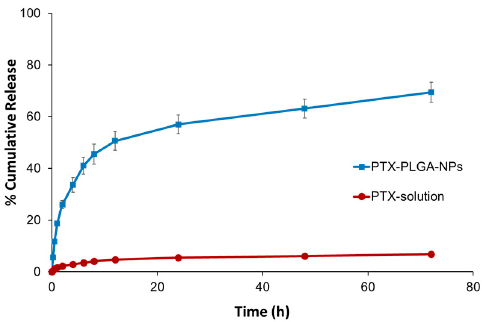
Figure 8. In vitro release profiles of PTX from the optimized PTX-PLGA-NPs formulation and its solution in NMP in isopropanol: 0.9% normal saline (30:70, v / v ) at 37 °C. Data points are mean ± SD ( n = 3).